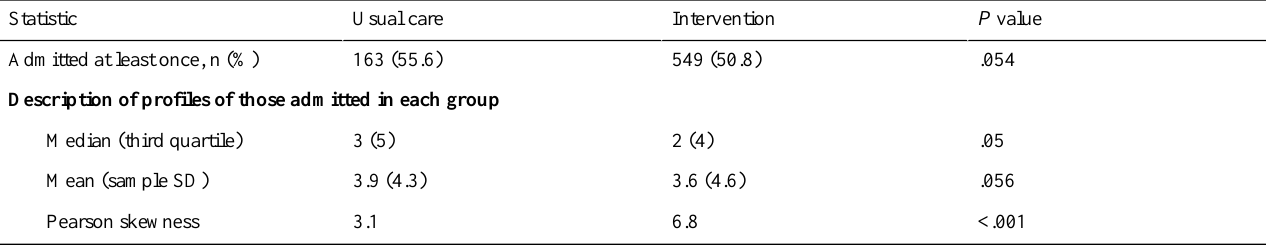
P valueInterventionUsual careStatistic